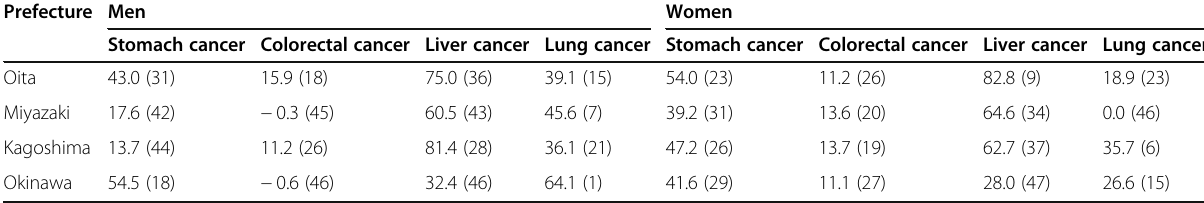
Table 3 Decreasing rates of cohort effects among prefectures and the ranks of the decreasing rates (Continued) Prefecture